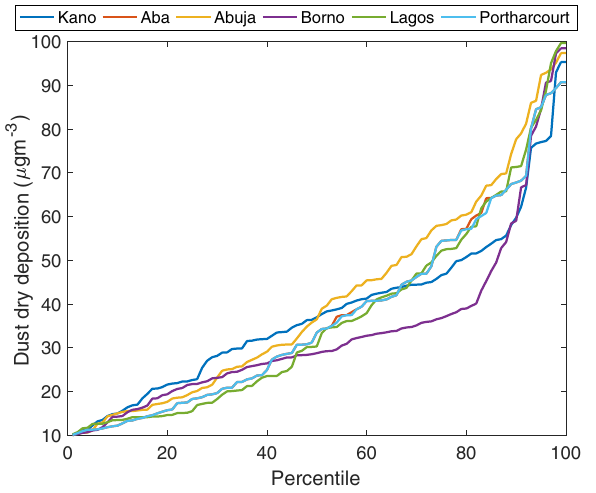
Figure 9. Percentile classification of dry dust deposition.